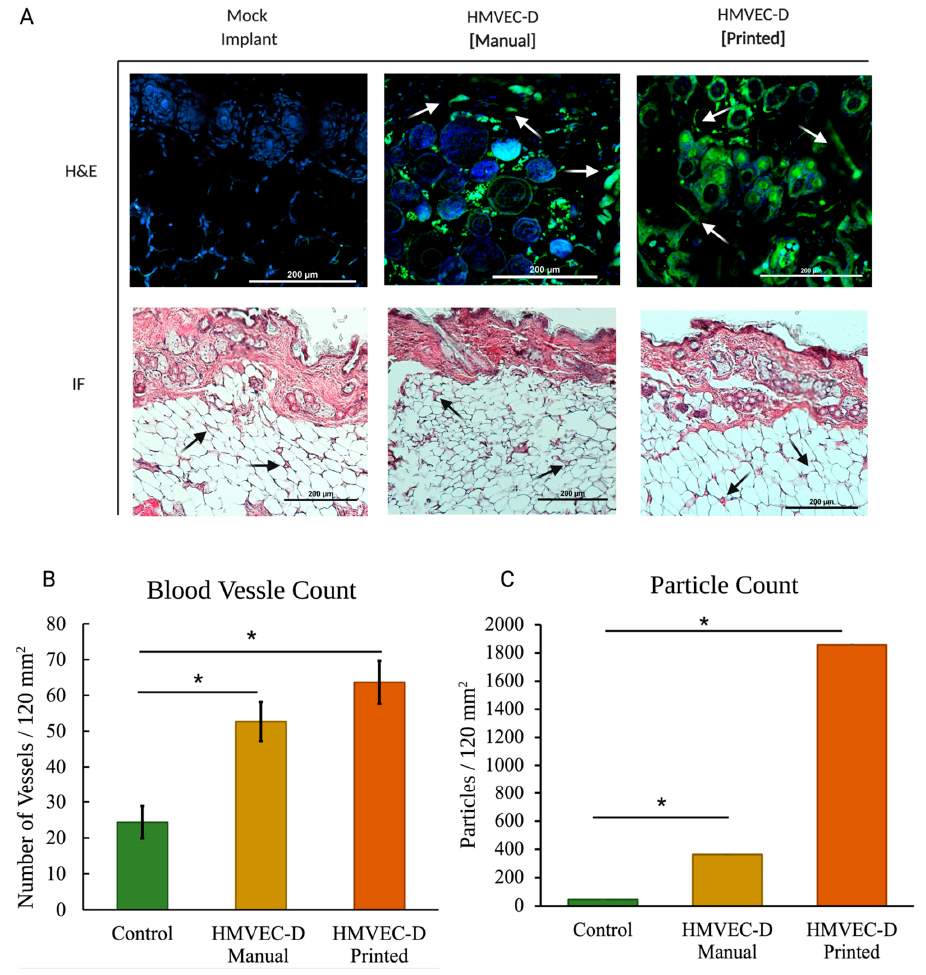
Figure 3. ( A ) In vivo vascular formation for the NSG-SMG3 mice. Hematoxylin, eosin, and immunohistochemistry-stained (blue-DAPI, green-CD31). Arrows indicate microvascular formation. ( B ) For blood vessel quantification of NSG-SGM3 mice, we observed more than twice the amount of vessels when comparing the inkjet-printed implants to those from the mock control group; specifically, a 2.16 increase in vessels per area was counted. Similarly, 2.89× of vessels were seen for TIB implants vs. manually seeded implants in the NSG-SGM3. ( C ) Particle analyses of the CD31-stained NSG-SMG3 tissue sections display a 7.8× increase for the manually seeded cells when compared to the control group and a 40× increase when compared to the TIB group. * denotes statistical significance p < 0.05